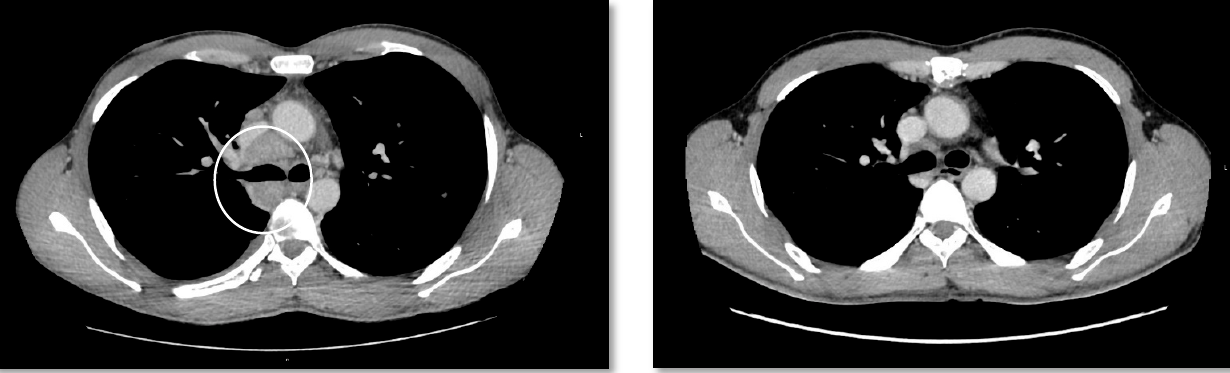
Figure 4. The dynamics of control CT scans before treatment and after 12 months of treatment.